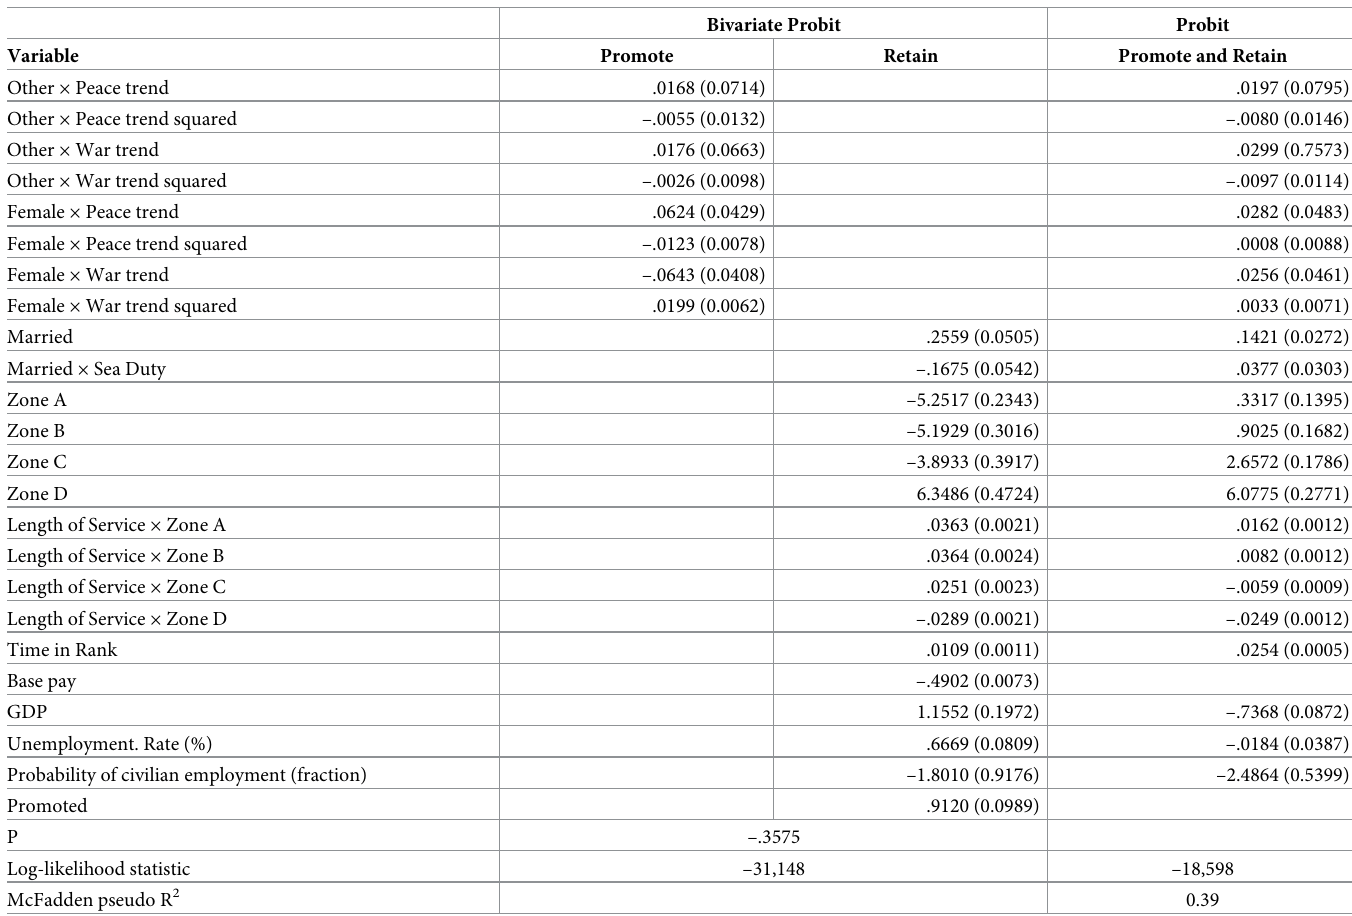
promotion ratio Black/White is about 89%, while during the war period it goes down to 79%. Similarly, for Hispanics these ratios are 84% and 72% respectively for peace and war periods. For Females the ratios (Female/Male) are 91% and 75% respectively for peace and war periods. These are big differences in the promotion rates. Table 2. The bivariate probit (left panel) and probit predictions table (right panel). Retained Promoted